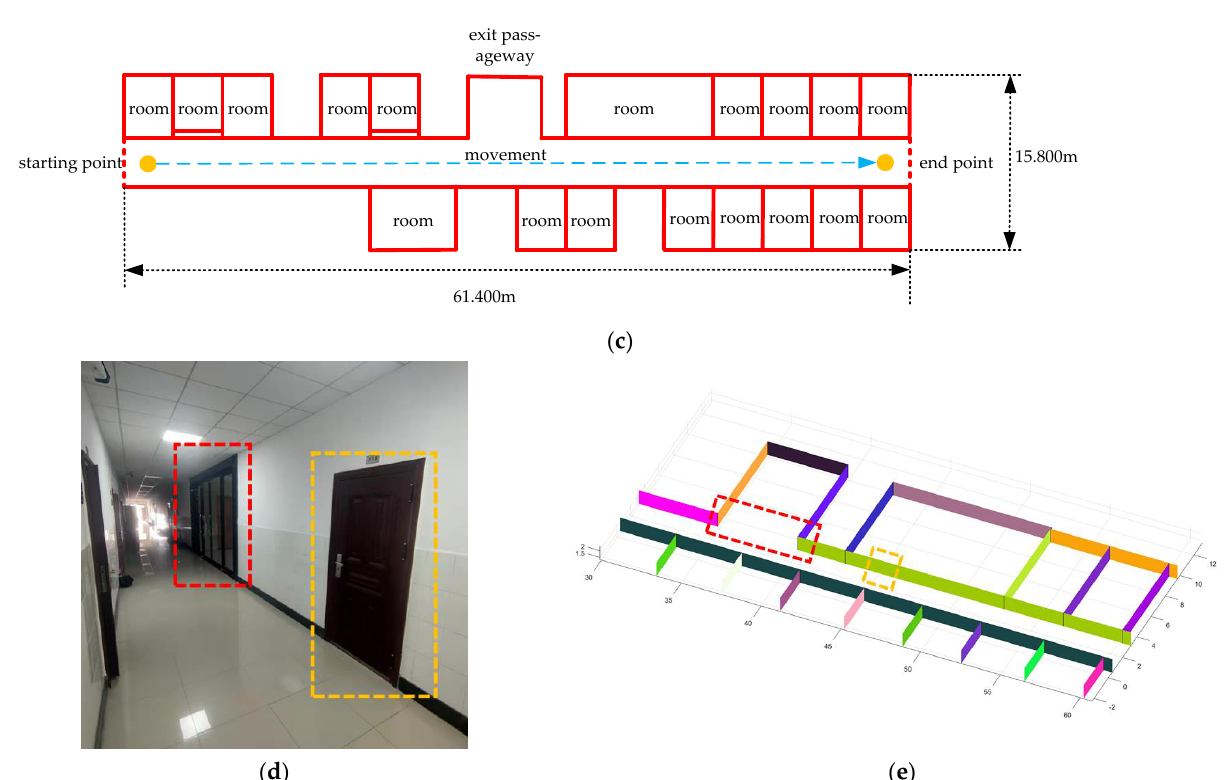
Figure 24. The resulting presentation of scene 3: ( a ) point cloud data of scene 3; ( b ) the experimental results; ( c ) the two-dimensional plan of the data; we moved and scanned each room for a few seconds as we passed it; ( d , e ) we marked two locations in the simulation results that corresponded to the real world.